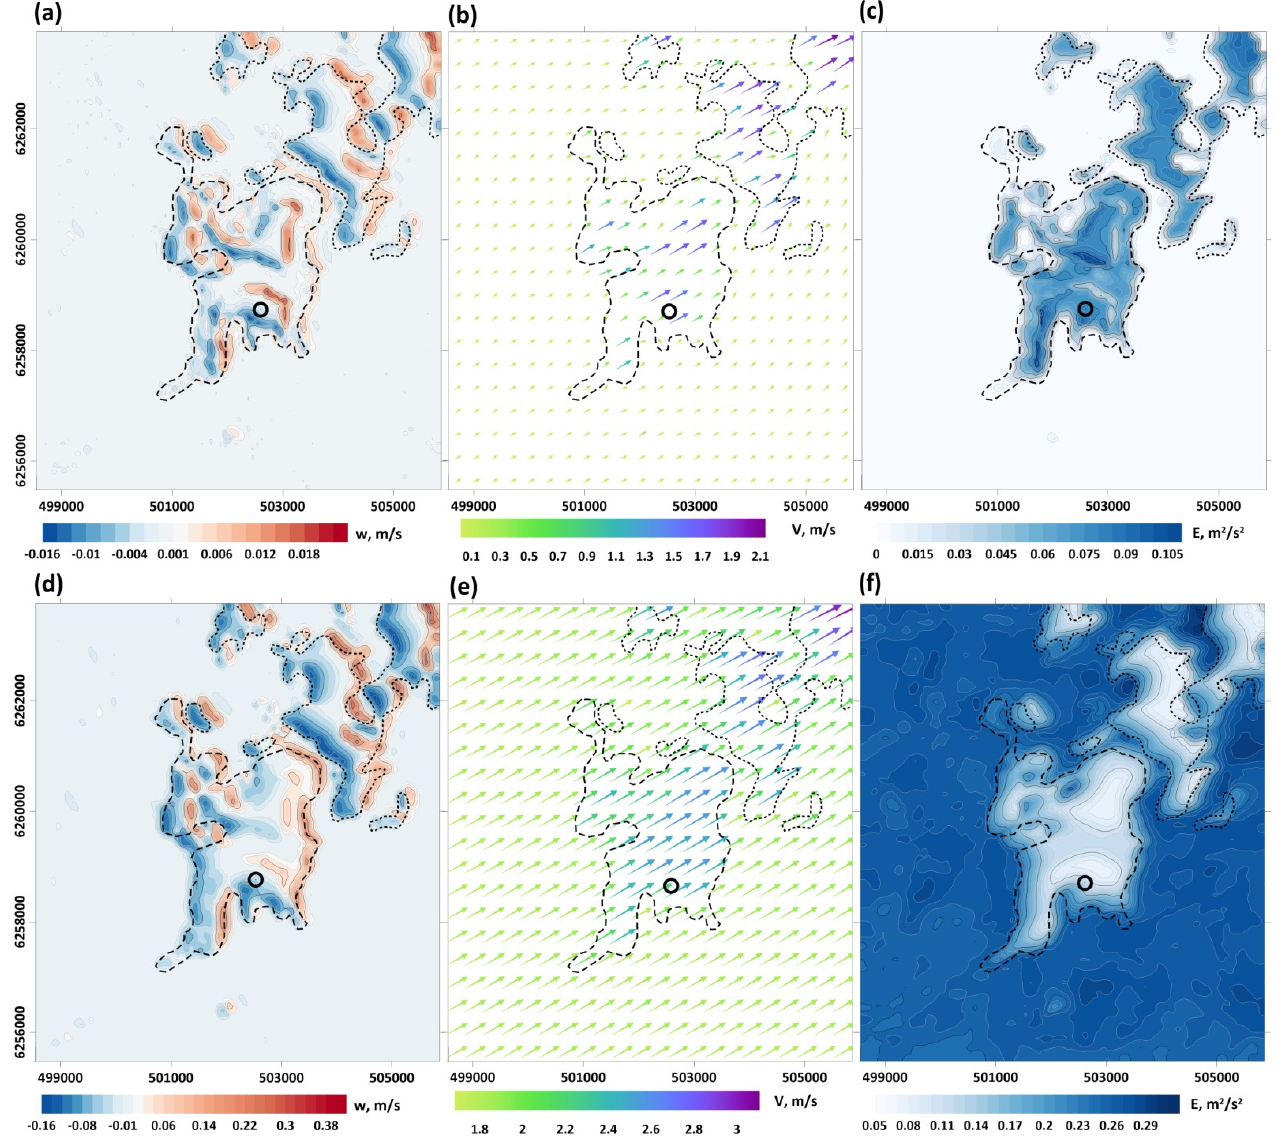
Figure 4. Modeled vertical ( a , d ) and horizontal ( b , e ) flow velocity, and turbulent kinetic energy ( c , f ) distributions at the heights of 3 ( a – c ) and 30 ( d – f ) m above the ground. Calculations were performed using meteorological data at 14:00 on 25 June 2016. The wind direction at the upper boundary of the modeling domain is southwest. The medium-dashed line shows the peatland boundary. The short-dashed line shows the boundaries of abandoned lands with grassy vegetation and open places. The black circle indicates the location of the eddy covariance flux station. The negative vertical flow component corresponds to the downward air flows, and positive, to the upward ones. The coordinate system is Universal Transverse Mercator (UTM, 36N).